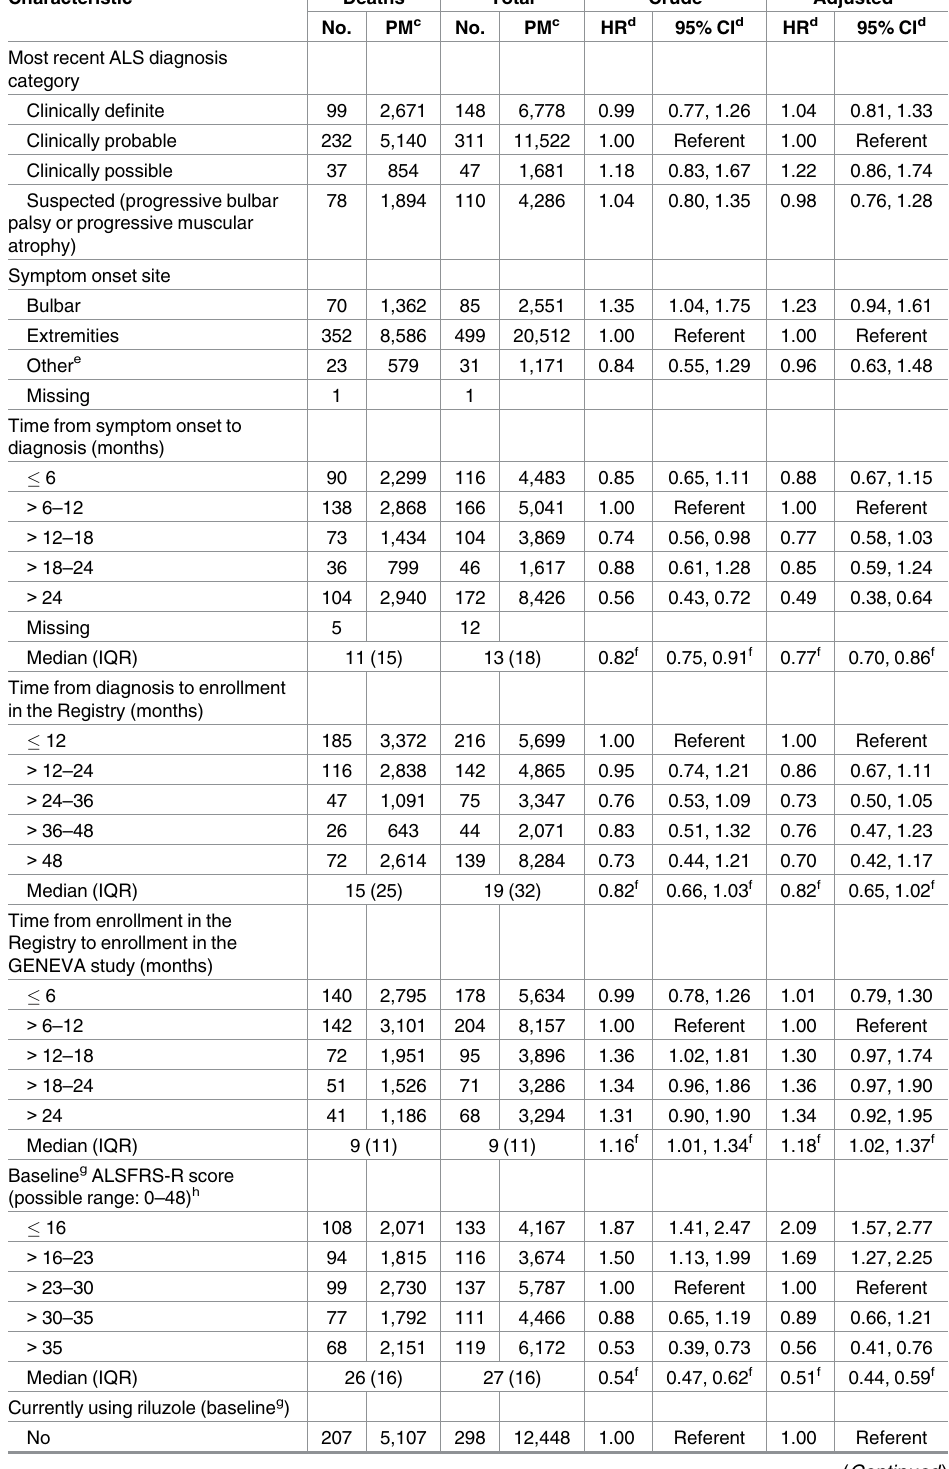
Table 2. Clinical characteristics of amyotrophic lateral sclerosis deaths and total cases a in GENEVA, United States of America, 2005–2013.